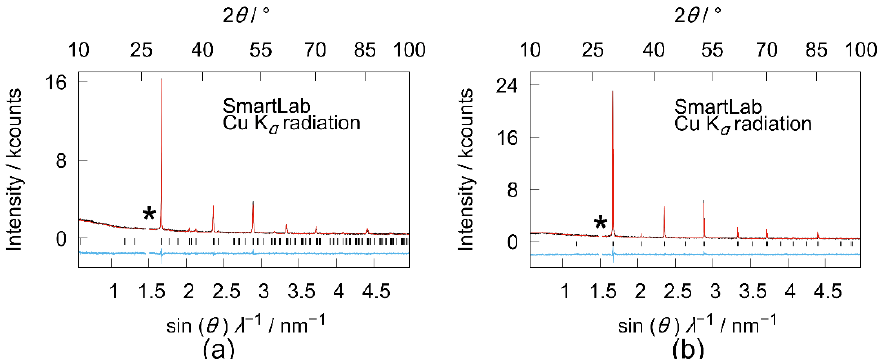
Figure 13. Refinements of the crystal structure of Ba 2 In 1.8 Cr 0.2 O 5 under 0.15 MPa nitrogen pressure (first batch) with a flow rate of 20 sccm ( p = 0.15 MPa, p (O 2 ) < 5 ppm, p (H 2 O) < 5 ppm): ( a ) at 293 K, I 4 cm , a = 5.9949(2) Å, c = 16.946(1) Å, R p = 4.18%, R wp = 5.18%; ( b ) at 1123 K, Pm 3 m , a = 4.25874(4) Å, R p = 4.15%, R wp = 5.28%; excluded region due to Cu-K β contribution is marked with *.